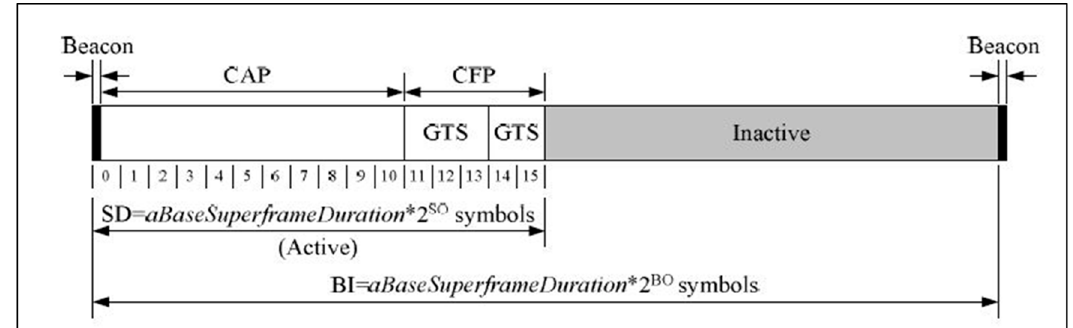
Figure 1. IEEE 802.15.4 superframe structure.